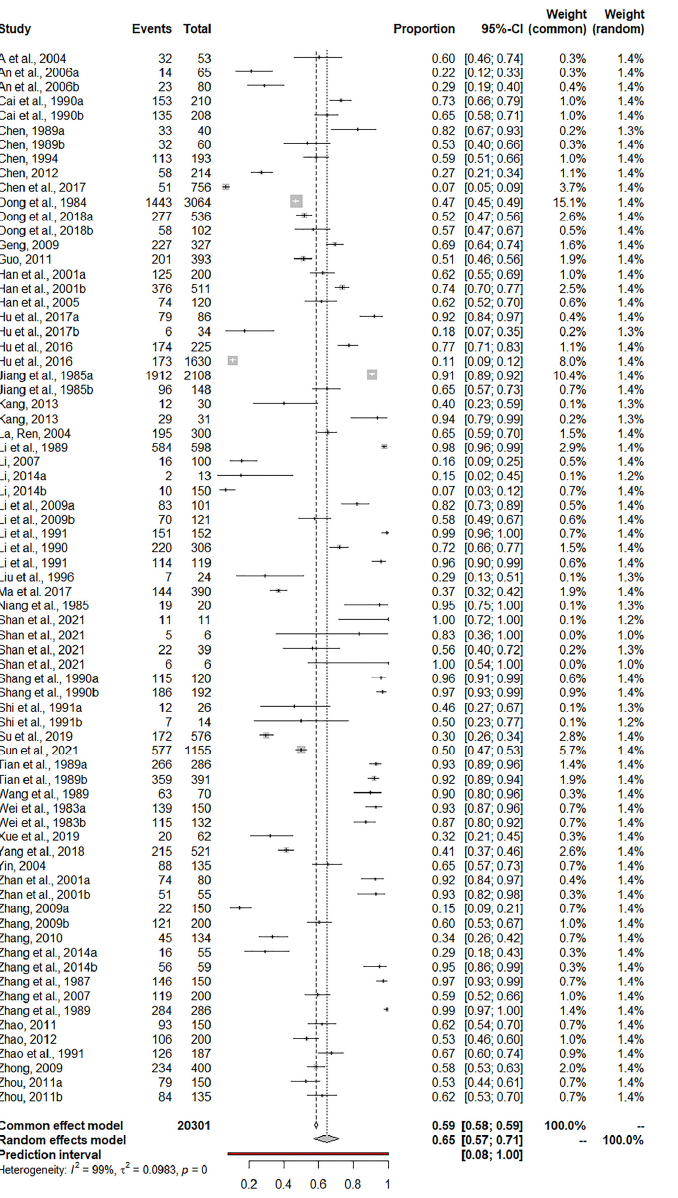
Figure 2. Forest plot of the prevalence of Sarcocystis infection among ruminants in China. CI: confidence interval. The first column “Study” included “Author + Year” [7,10–62]. Table 2. Normal distribution test for the normal rate and the different conversion of the normal rate.